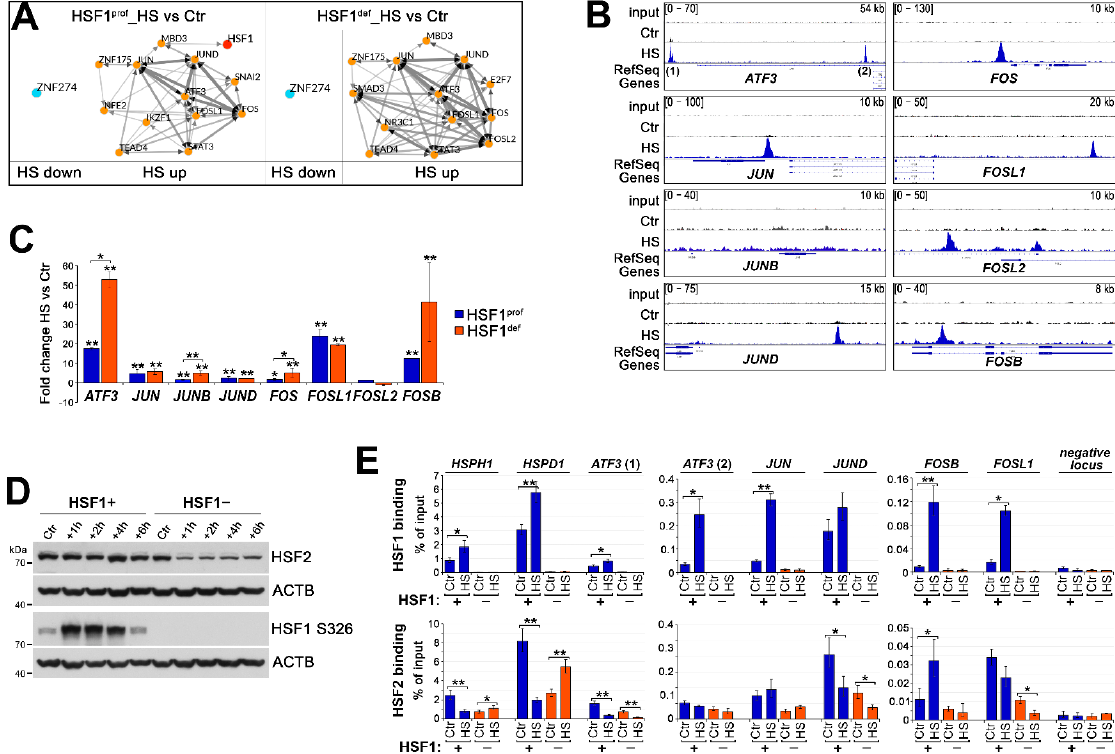
Figure 5. Heat shock initiates the formation of a transcriptional regulatory network that may be stronger in HSF1-deficient MCF7 cells. ( A ) Networks of upstream regulators of HS-stimulated (HS